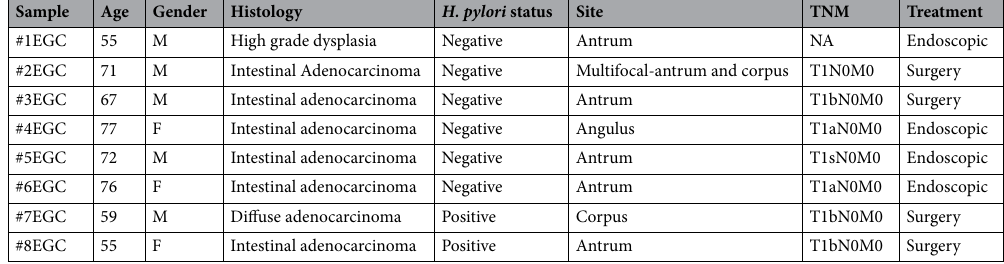
Table 2. Characteristics of patients with high grade dysplasia or early gastric cancer (EGC). NA not applicable.